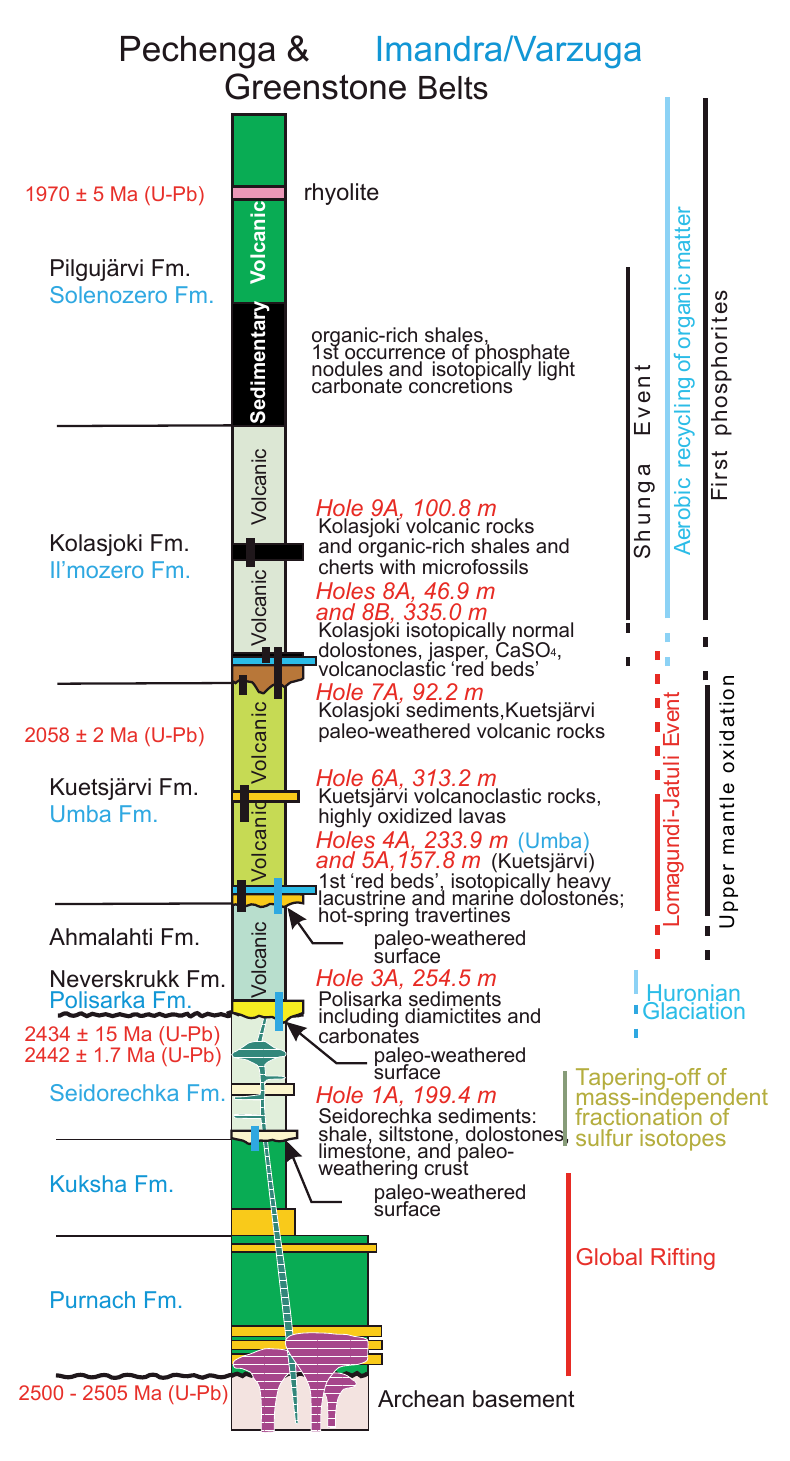
Figure 4. Composite (~10,000-m-thick) and simplified Paleoproterozoic section for the Pechenga and Imandra/Varzuga Greenstone Belts linked to major paleoenvironmental events. Radiometric dates from bottom to top are from Amelin et al. (1995), Melezhik et al. (2007), and Hanski (1992). The Pechenga Belt stratigraphy is shown in black-face letters, and the drilled holes by vertical black lines; features for the Imandra/Varzuga Belt are in blue. The number of the drillhole and its depth are shown in red-face letters; this is followed by text briefly describing rock lithologies intersected by the